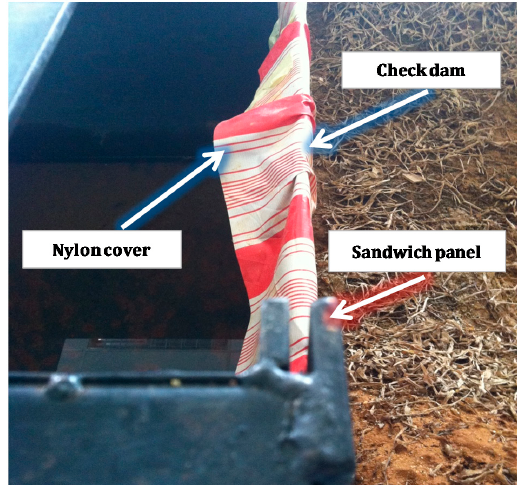
Figure 2. The check dam at the end of the channel downstream.